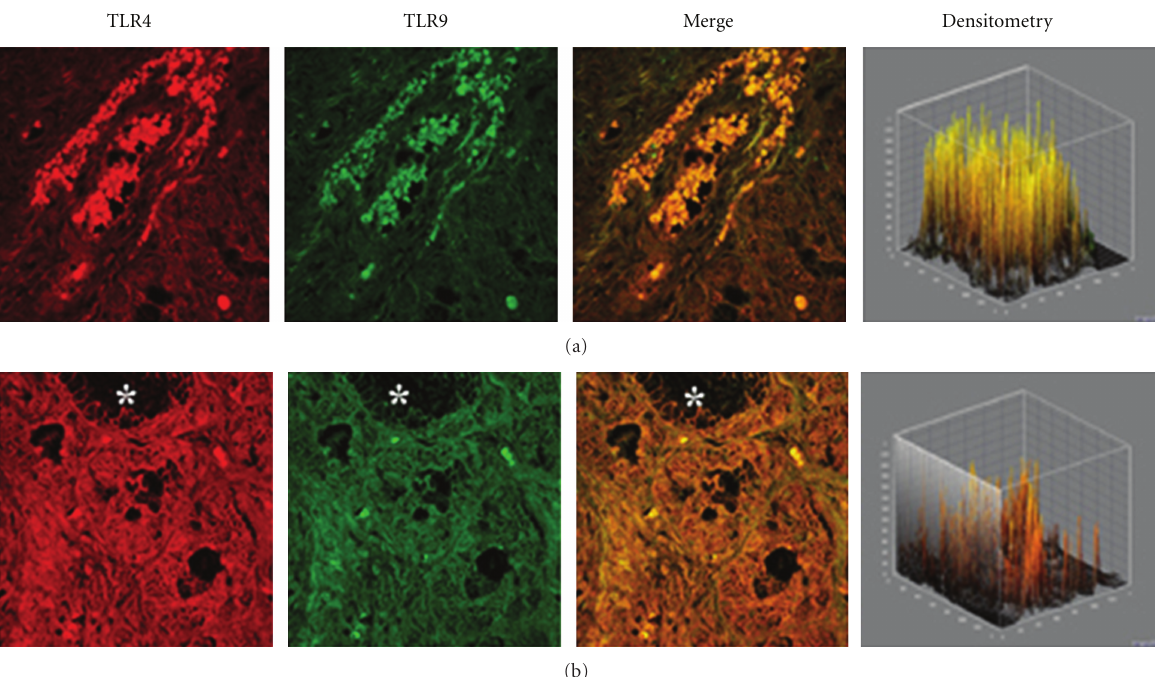
Figure 3: TLR4 and TLR9 expression in chronic rhinitis. Confocal analysis showing the coexpression of TLR4 and TLR9 (a) and (b). Note the strong structural alteration of the glandular epithelium associated with massive cellular infiltrates bearing both TLRs. Asterisk indicates the lumen of a nasal gland. × 60/oil-immersion.